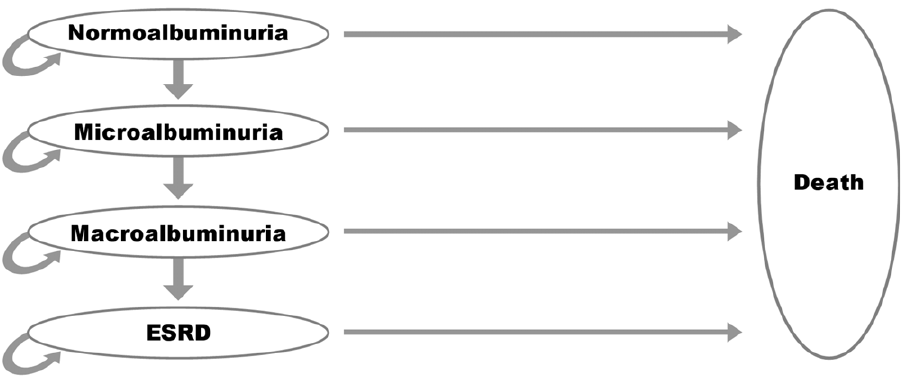
Figure 1. Schematic representation of the Markov decision model.